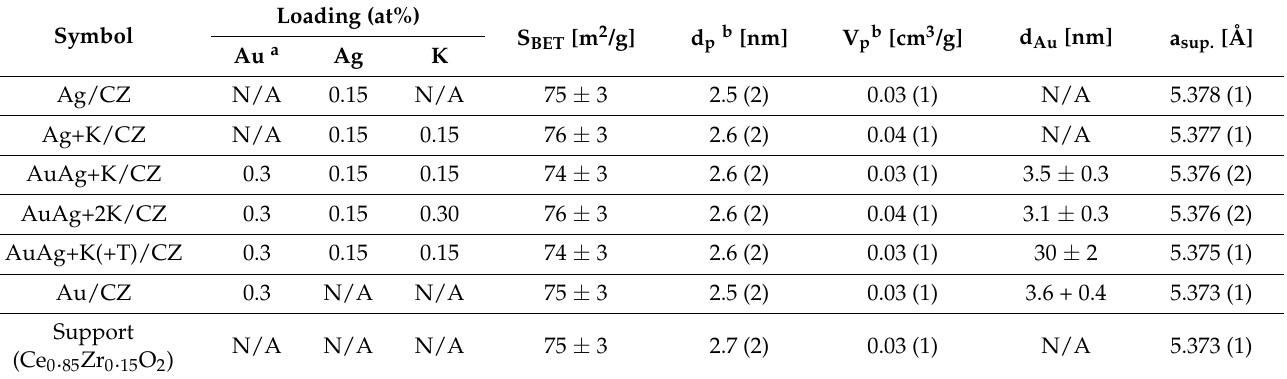
Table 1. Composition and properties of the